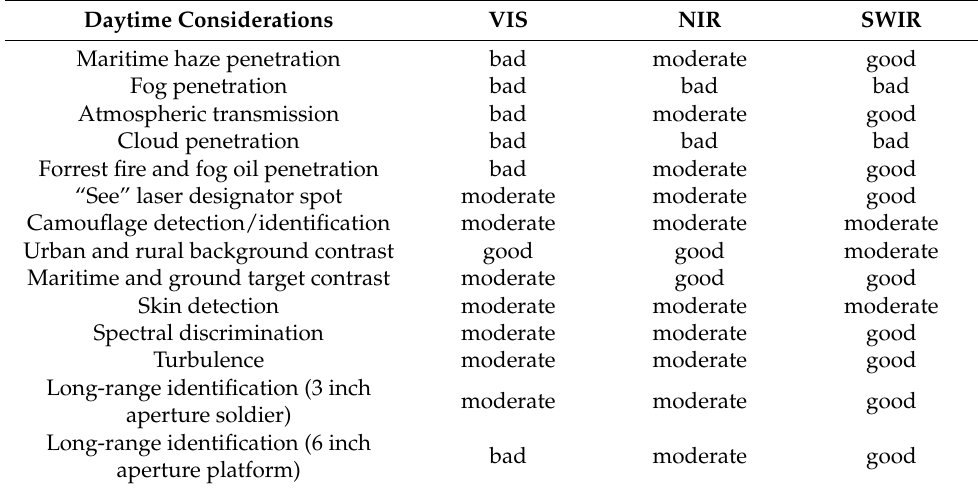
Table 1. Summary of band comparison for daytime